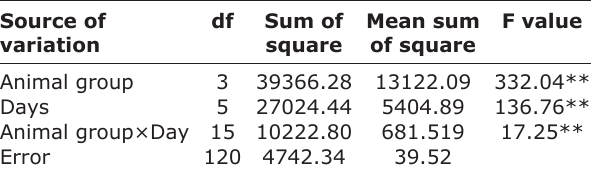
df Sum of Mean sum F value square of square